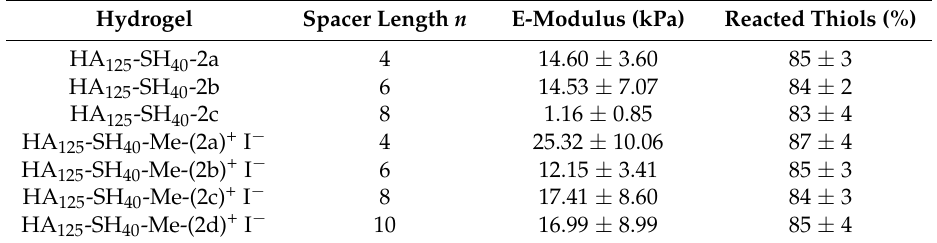
Table 1. Mechanical measurements of HA 125 -SH 40 - 2a–c and HA 125 -SH 40 - Me-(2a–d) + I − hydrogels. The ratio of reacted thiols was determined by an adapted Ellman’s assay. All values represent mean and standard deviation of three different experiments.